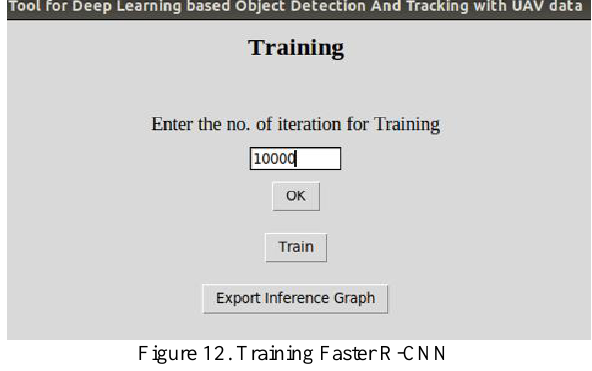
Figure 12. Training Faster R-CNN